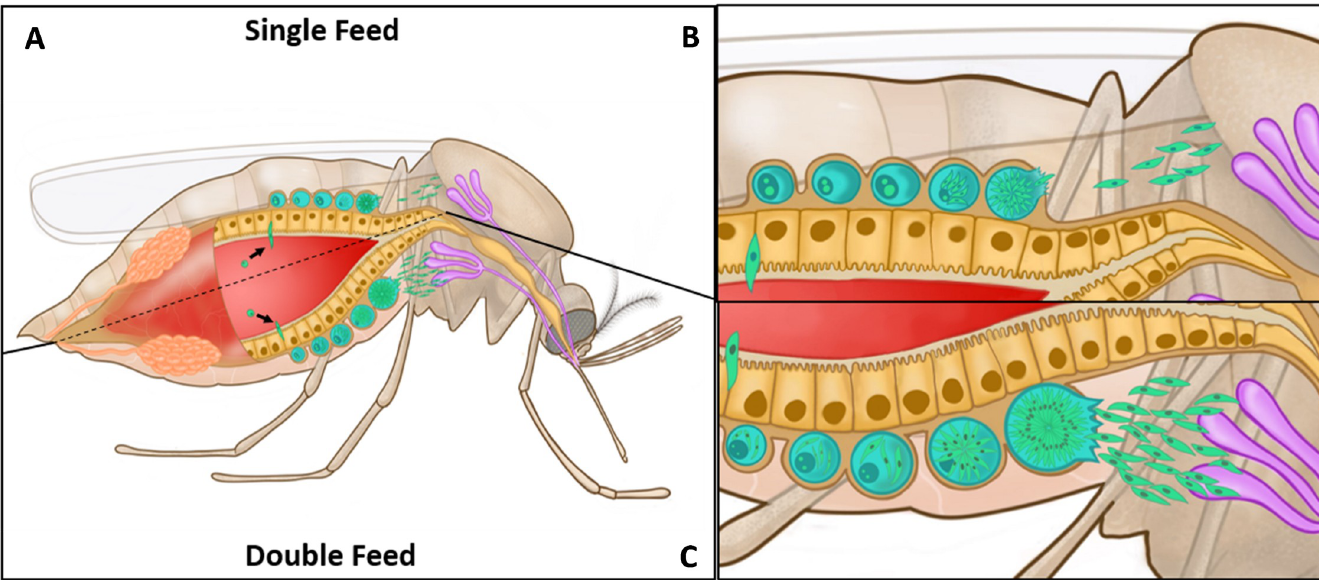
Fig 2. Additional blood meals increase the transmission potential of malaria-infected mosquitoes. (A) Cross section of an An . gambiae mosquito with the developmental stages of the human malaria parasite P . falciparum under single-feed (top) and double-feed (bottom) scenarios. Compared to a single blood meal (B) , P . falciparum –infected mosquitoes provided with an additional blood meal increase oocyst growth rates and sporogony, resulting in faster rates of sporozoite salivary gland invasion and reducing the time required for malaria parasite transmission (C) .